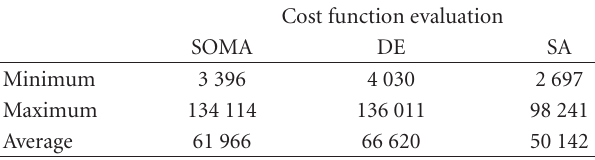
Table 4: Cost function evaluation for SOMA, DE, and SA.